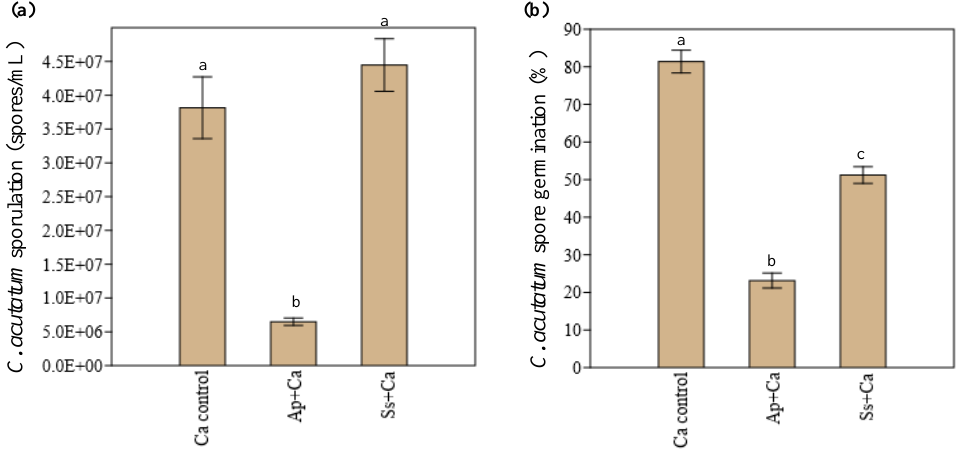
Figure 2. Sporulation ( a ) and spore germination ( b ) of Colletotrichum acutatum in co-culture with Aureobasidium pullulans (Ap + Ca) or Sarocladium summerbellii (Ss + Ca) and in control (single culture of C. acutatum , Ca control), after 10 days of interaction. Bars with different lowercase letters indicate significant differences ( p < 0.05, n = 5).